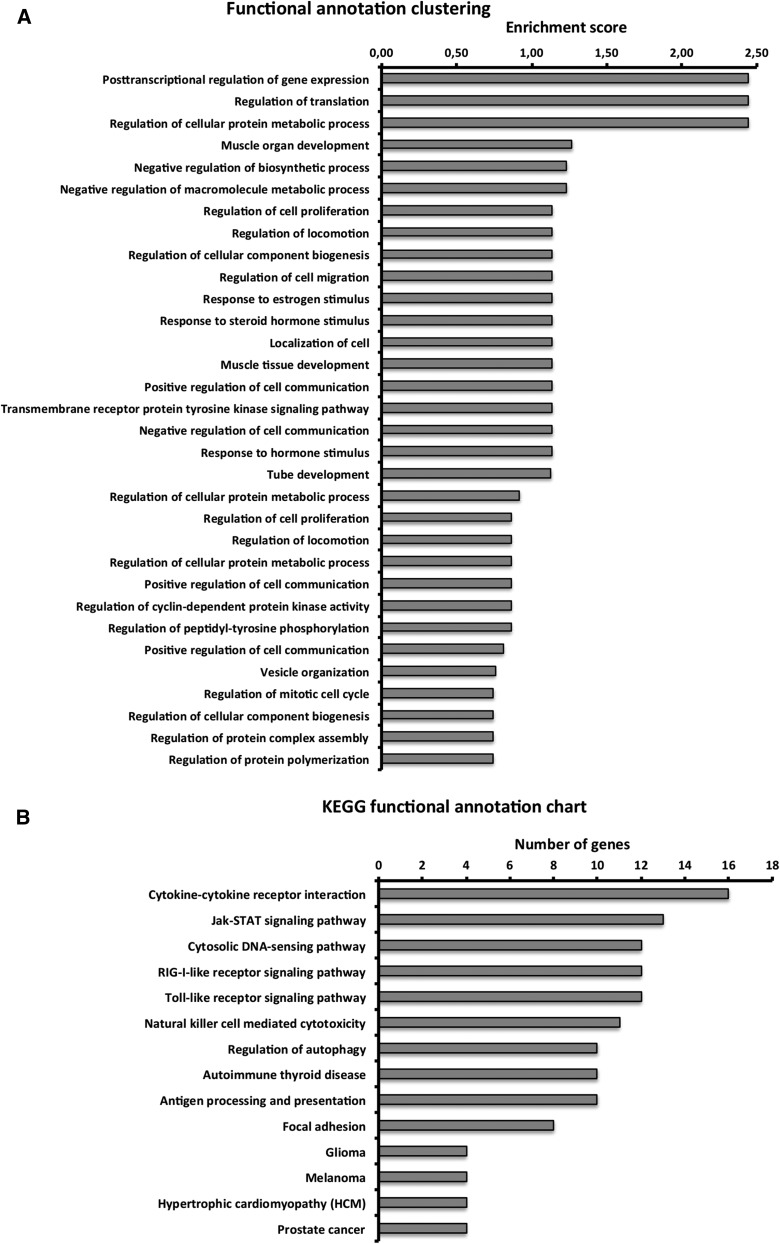
DAVID clustering analysis showing (A) functional annotation clustering based on biological processes and (B) Kyoto Encyclopedia of Genes and Genomes (KEGG) functional annotation. DAVID, The Database for Annotation, Visualization, and Integrated Discovery.